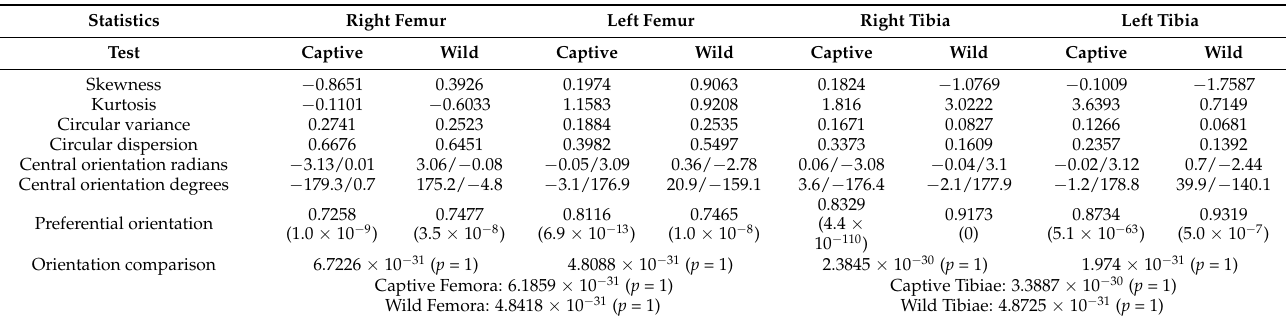
Figure 10. Rose diagrams obtained for the calculated orientation patterns between the documented tooth scores (red lines) and the corresponding longitudinal bone axis of the ( a ) right femora modified by captive wolves; ( b ) right femora modified by wild wolves; ( c ) left femora modified by captive wolves; ( d ) left femora modified by wild wolves; ( e ) right tibiae modified by captive wolves; ( f ) right tibiae modified by wild wolves; ( g ) left tibiae modified by captive wolves; ( h ) left tibiae modified by wild wolves. The box legend indicates the rose diagram preferential orientation (from distal to proximal long bone epiphysis). Table 3. Results obtained for the orientation analyses performed on the tooth scores identified on the deer femora and tibiae modified by captive and wild wolves.